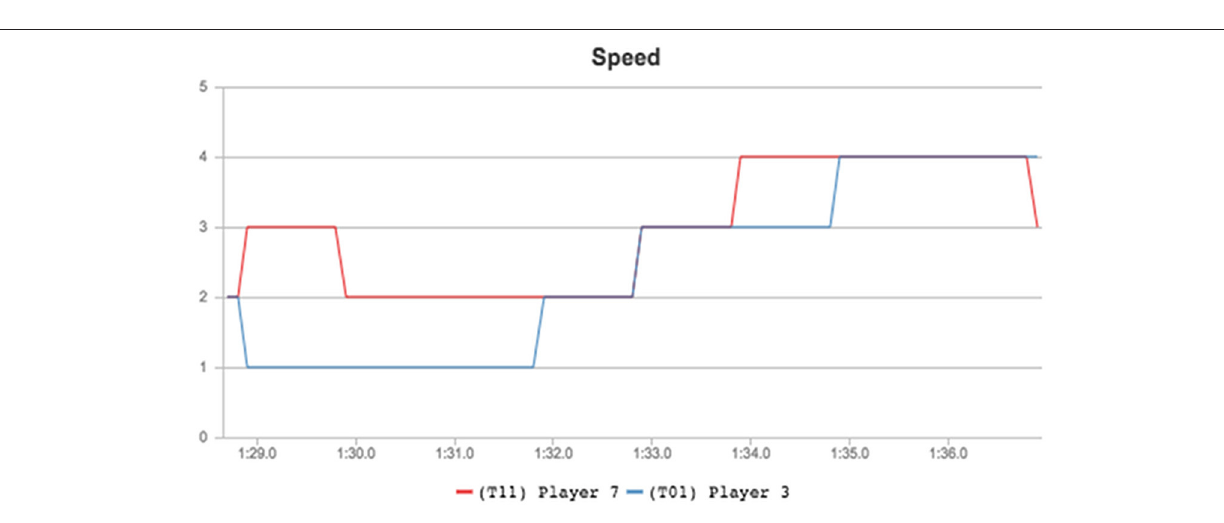
FIGURE 5 | Speed comparison between players 7 (attacking) and 3 (defending) during the analyzed